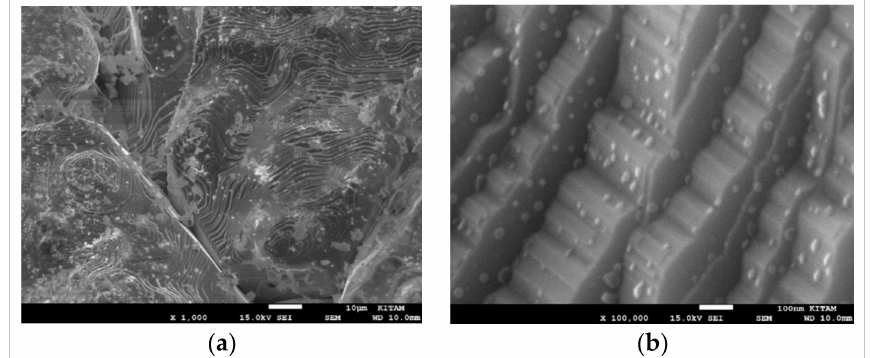
Figure 7. Dominant structure of Dielectric Barrier Discharge (DBD)-plasma (100 W) treated BaTiO 3 particles at two magnifications with composition evaluated by EDS, ( a ) Mag. = 1 k; [O] = 0.679; [Ti] = 0.164; [Ba] = 0.157; [Ti] / [Ba] = 1.04; [O] / ([Ti] + [Ba]) = 2.12. ( b ) Mag. = 100 k; [O] = 0.684; [Ti] =